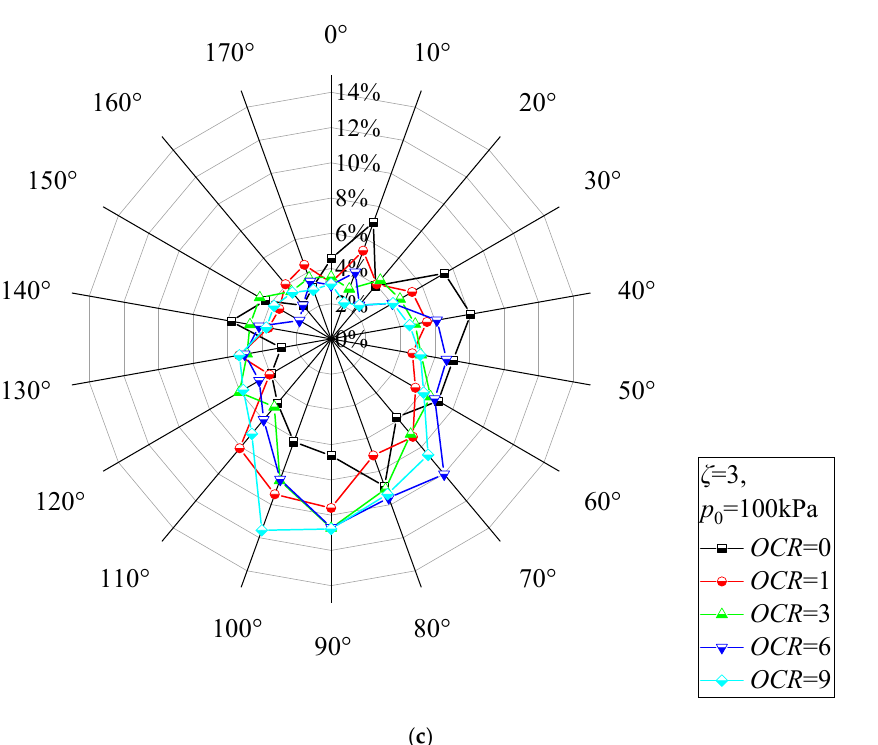
Figure 12. Directional frequency distribution diagram before and after loading under different test conditions: ( a ) SEM-A, ( b ) SEM-B, and ( c ) SEM-C.